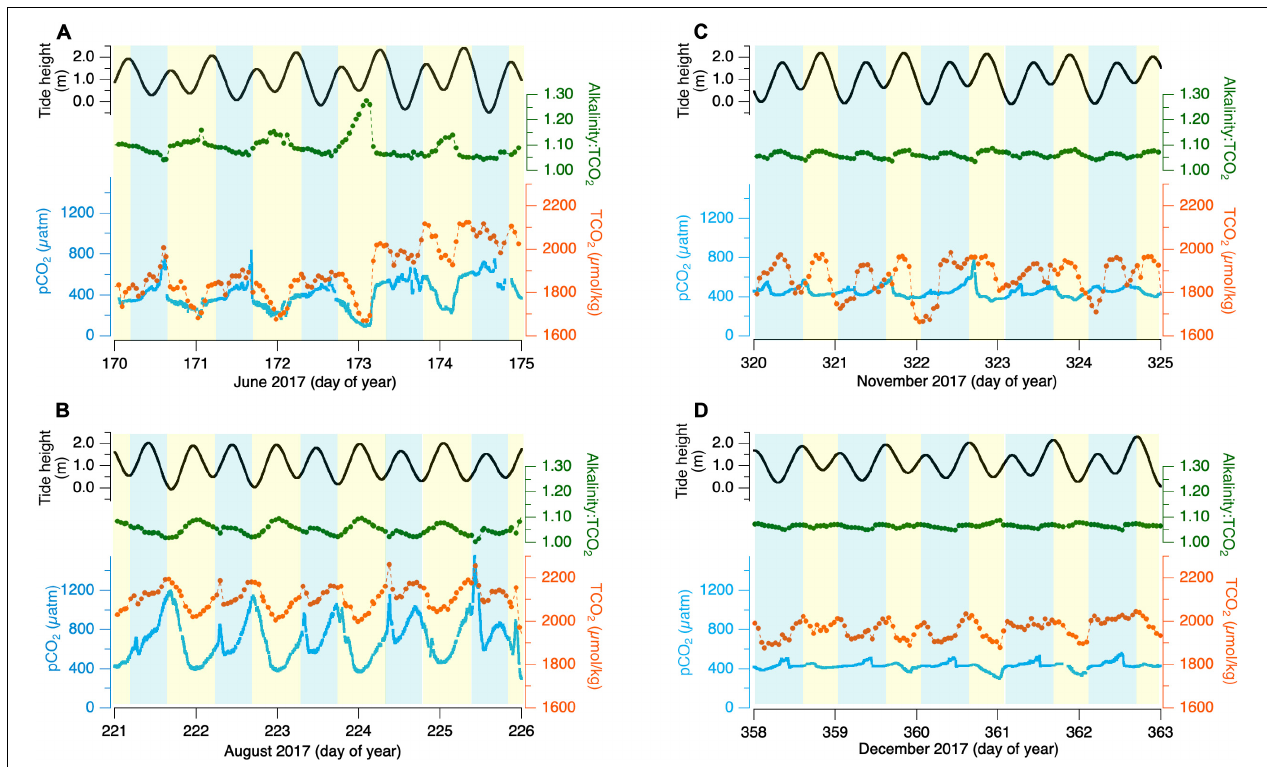
FIGURE 6 | pCO 2 (blue line), TCO 2 (orange dots connected by a line), Alk:TCO 2 ratio (red starts connected by a line), and estimated tide height (black line) for two 7-day periods during summer (A,B) and winter (C,D) of 2017 with tide-phasing ∼ 90 ◦ between top and bottom. Blue shading indicates local nighttime and yellow shading indicates